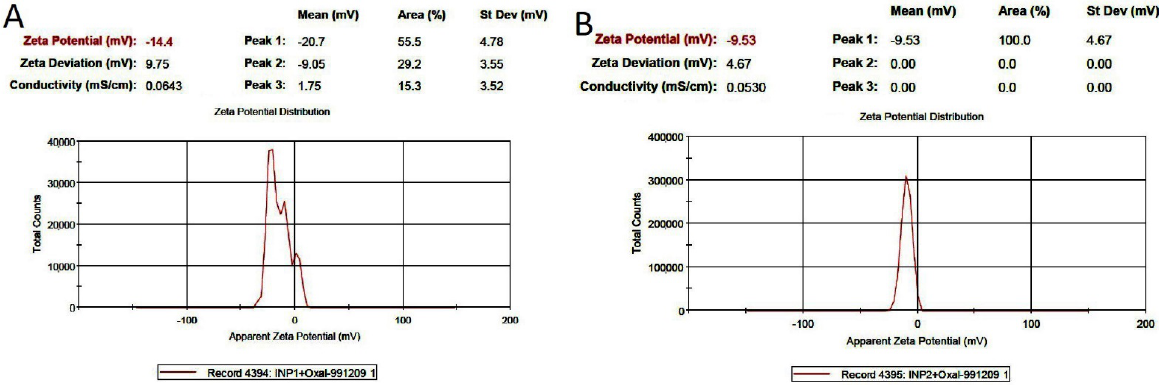
Figure 4. Zeta potential distribution of ( A ) Oxaliplatin-loaded Amino-PEG/iodine nanoparticles and ( B ) Oxaliplatin-loaded chitosan/iodine nanoparticles.